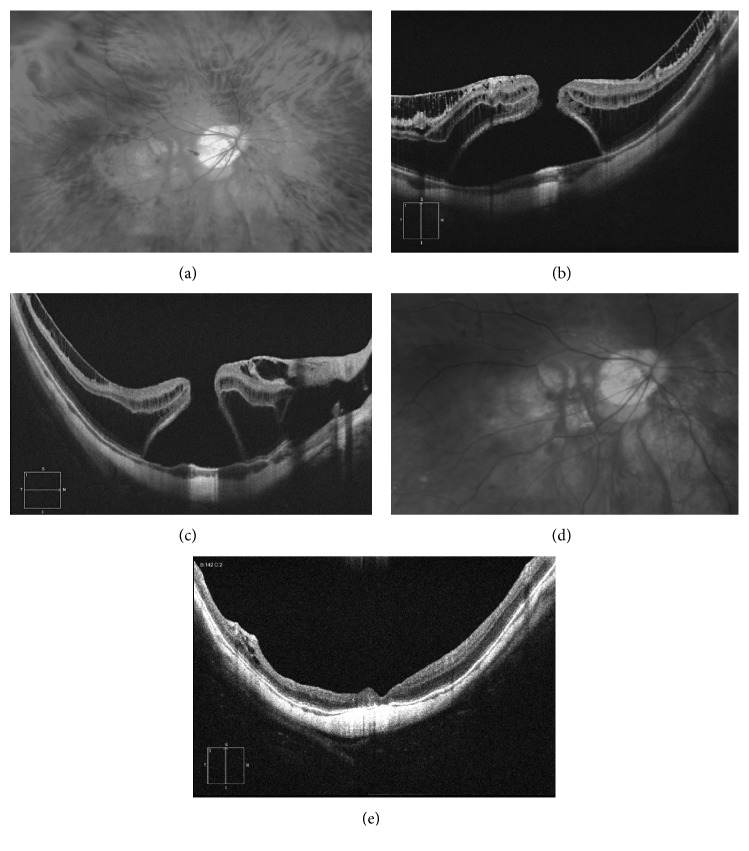
46-year-old woman with an axial length of 30.98 mm and a BCVA of 20/400, with inner and external retinoschisis and myopic macular hole. (a) Fundus photograph showing the chorioretinal atrophy and the macular hole. (b, c) Structural OCT showing the inner and external retinoschisis and the macular hole with subretinal fluid. Vitrectomy followed by inverted flap ILM technique was performed. (d) Postoperative retinography showing closure of the hole. (e) Structural OCT whit macular hole closure, disappearance of retinoschisis, but bad restoration of external retinal layers.